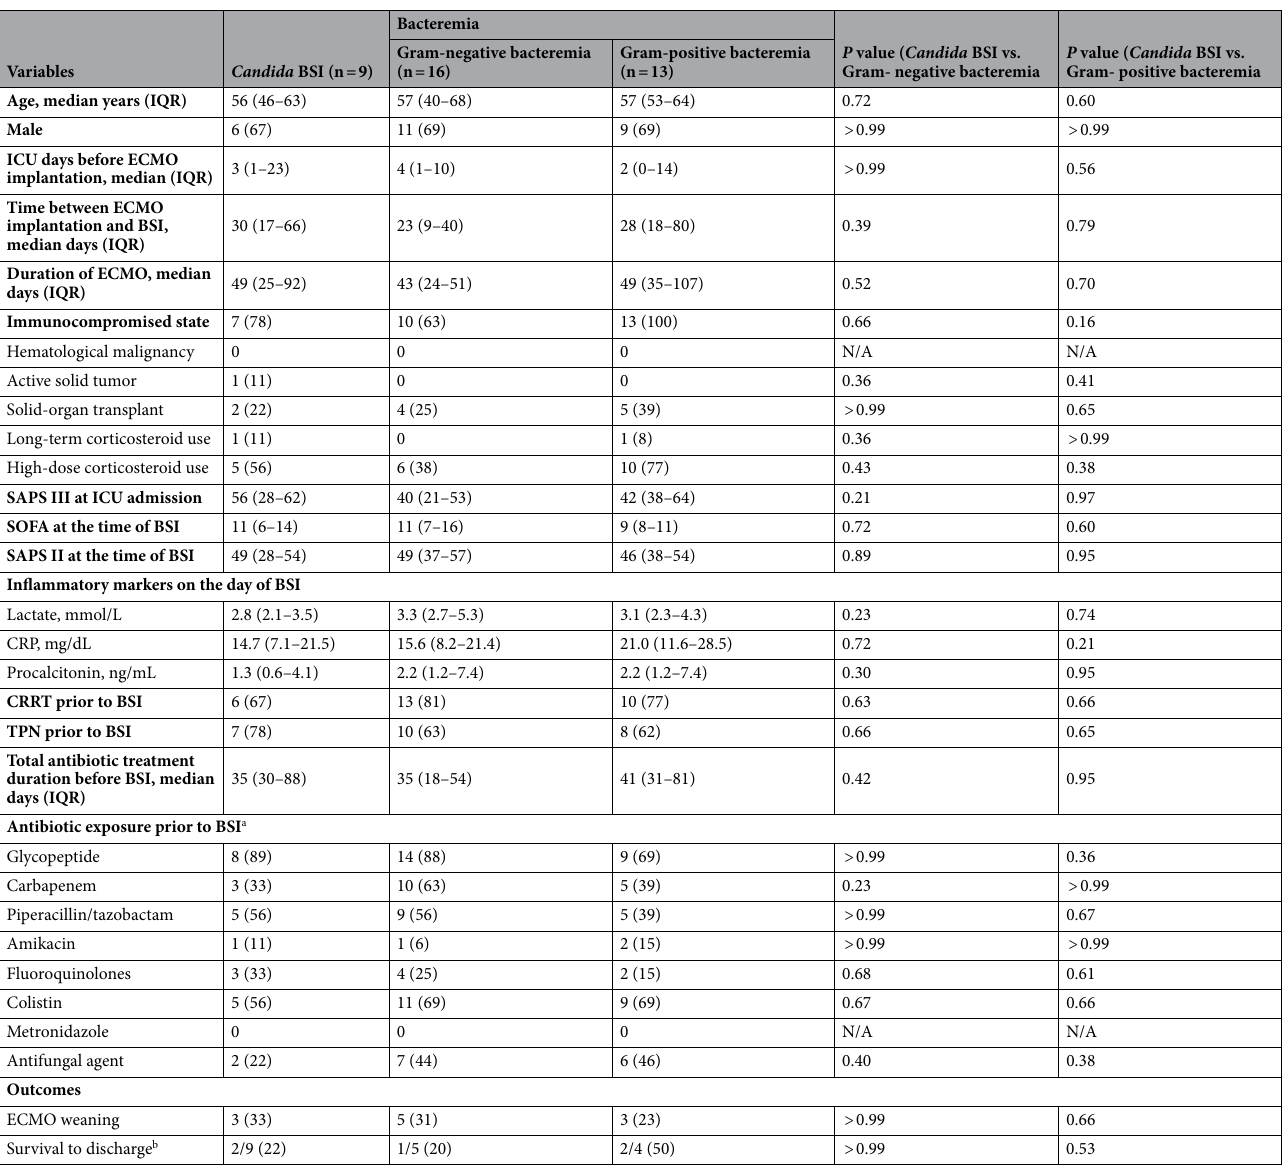
Table 4. Clinical characteristics and outcomes of the 9 cases of Candida BSI and 29 cases of bacteremia during venovenous extracorporeal membrane oxygenation (VV ECMO). BSI, bloodstream infection; CRP, C-reactive protein; CRRT, continuous renal replacement therapy; ICU, intensive care unit; IQR, interquartile range; SAPS, Simplified Acute Physiology Score; SOFA, sequential organ failure assessment; TPN, total parenteral nutrition. Data are presented as No. (%) unless indicated otherwise. a > 48 h of therapy within the 14 days prior to the BSI. b > Overall survival rates evaluated in patient-based, not